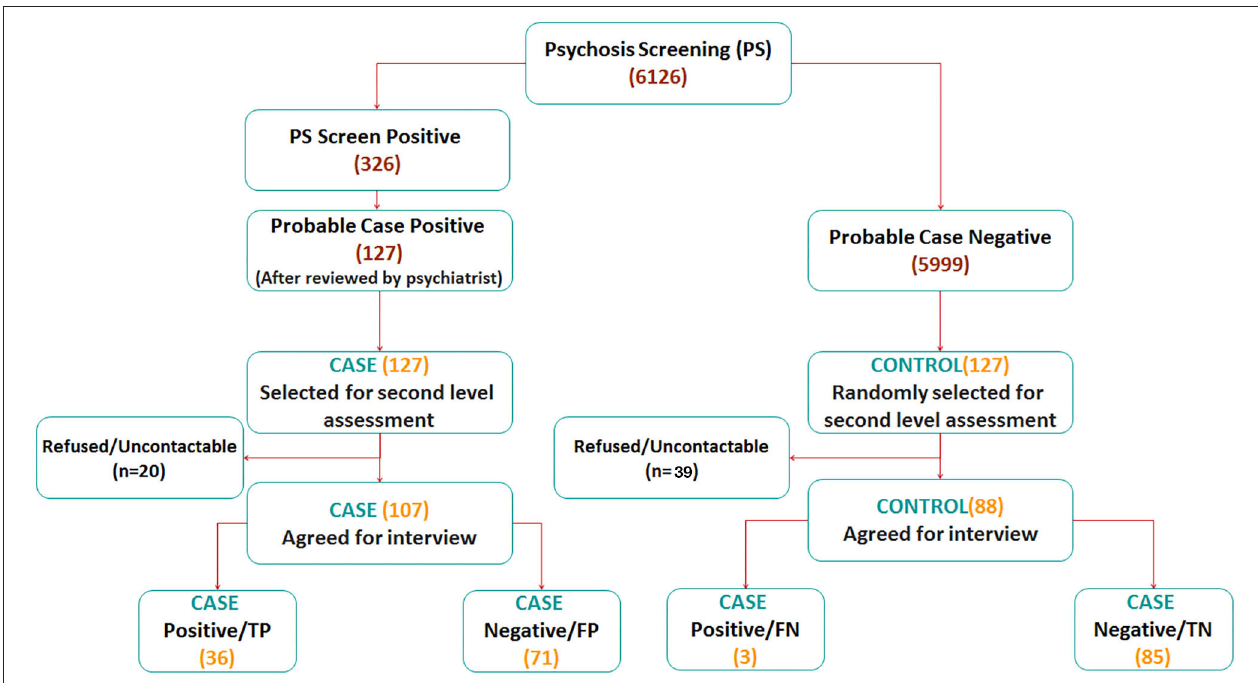
FIGURE 1 | Participant flow diagram for phase 1 and phase 2 of the